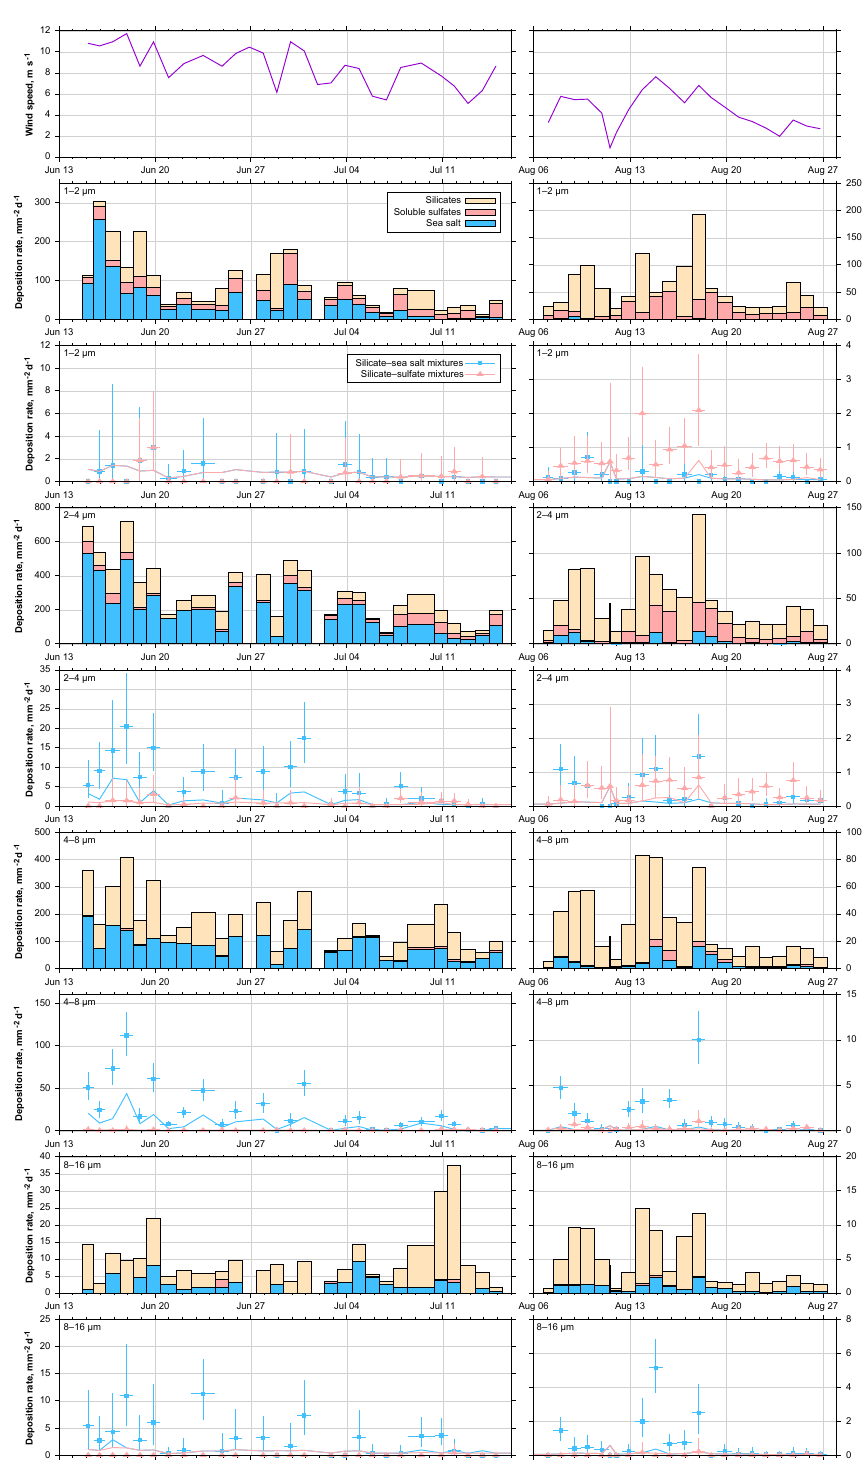
Figure 16. Time series of wind and particle number deposition rates for pure compounds and internally mixed particles for June–July 2013 and August 2016. Particle size ranges are given in the top left of each graph. The limit of detection for the number of internally mixed particles is shown as line in the according color. Where only the detection limit for silicate–sulfate mixtures is visible, both limits are